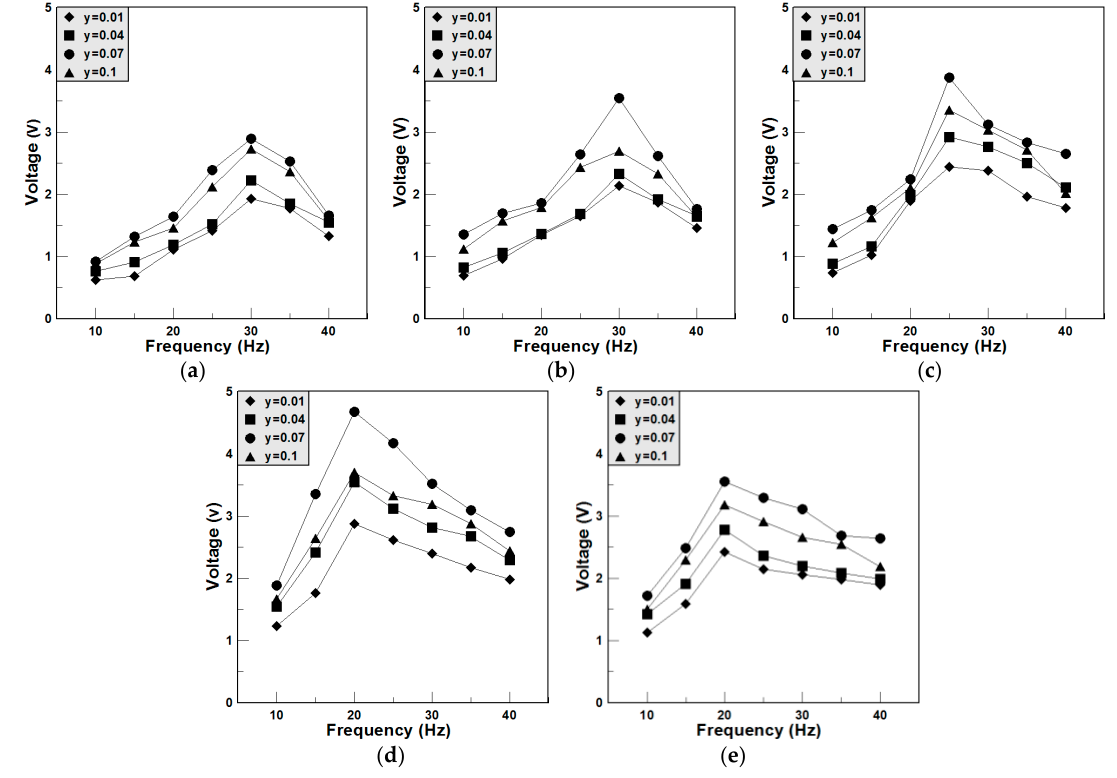
Figure 9. The peak voltage of the BCTS–yLiF sheets for different vibration frequencies. ( a ) Tip mass = 0 g; ( b ) Tip mass = 0.5 g; ( c ) Tip mass = 1.0 g; ( d ) Tip mass = 1.5 g; ( e ) Tip mass = 2.0 g.